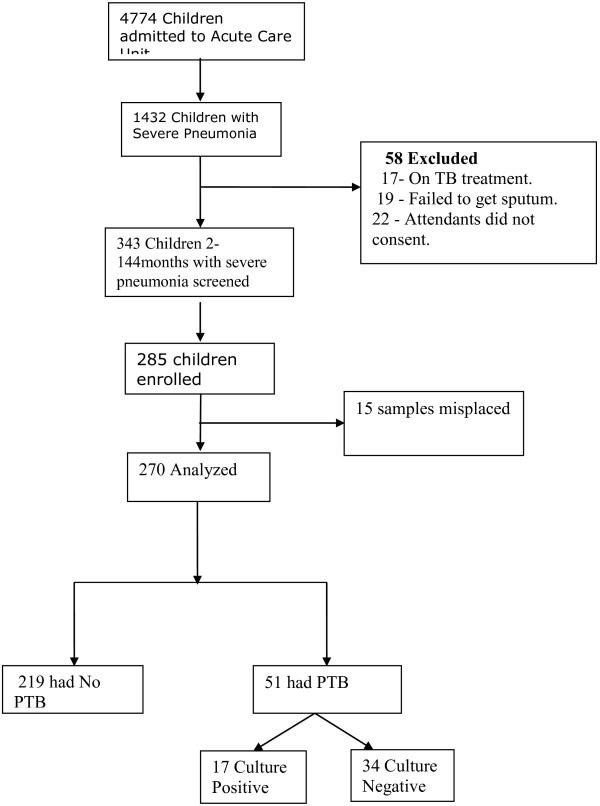
Study participant recruitment flow chart.